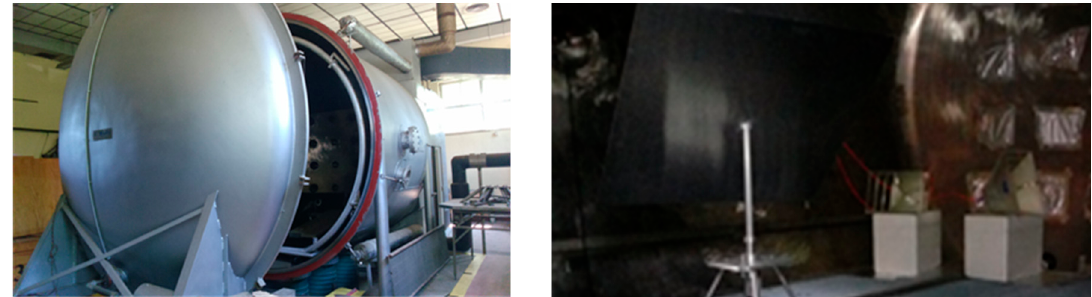
Figure 5. Outside (left) and inside (right) of the reverberation chamber at the Astronautics, Electrical and Energy Engineering Department (DIAEE) of the Sapienza University of Rome.